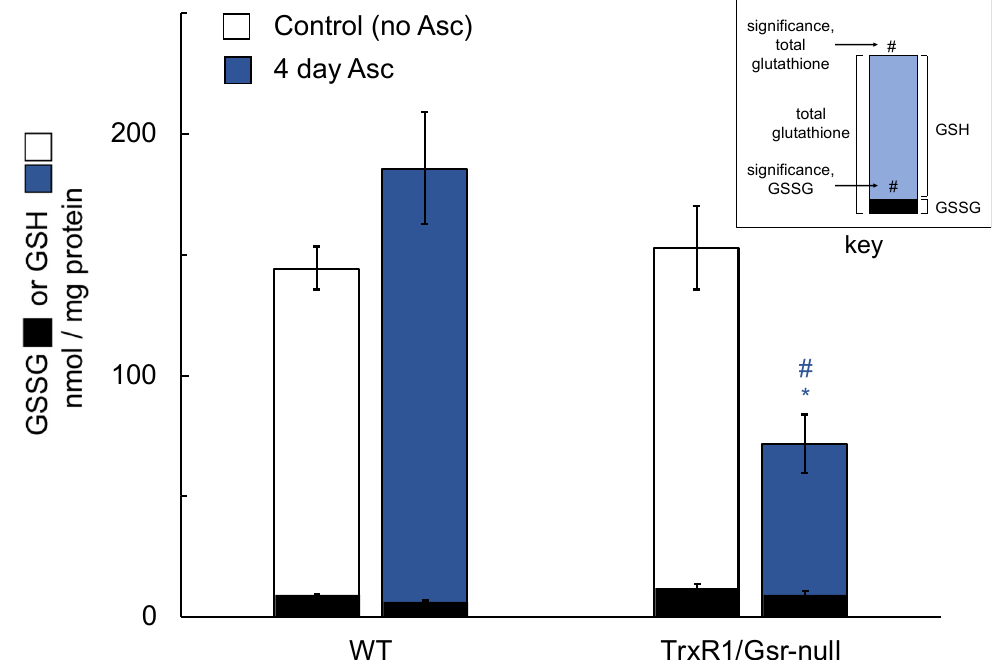
Figure 3. Hepatic levels of GSH and GSSG following 4-day ascorbate treatment. Mice received 0 (control) or 4 mg/g/day ascorbate × 4 days i.p. (Asc) and were harvested 3 h after the final inoculation. n ≥ 5 animals for each condition. Blue/white denotes GSH; black denotes corresponding GSSG in the same sample. Bars, mean ± s.e.m.; *, p ≤ 0.05 versus untreated control of same genotype; #, p ≤ 0.05 versus WT under same treatment using one-way ANOVA and Tukey–Kramer post hoc, pair-wise comparison.